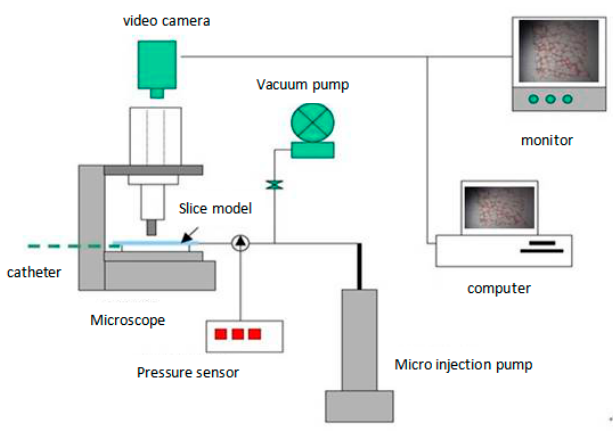
Figure 4. Experimental device diagram.